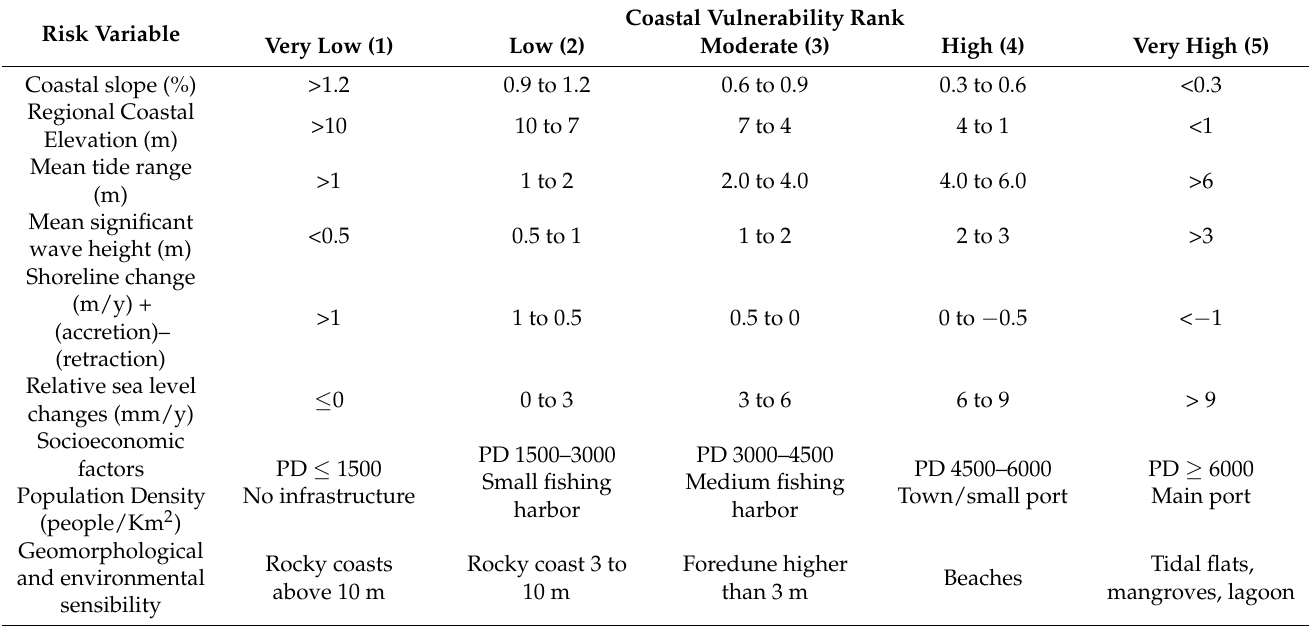
Table 2. Ranking of risk